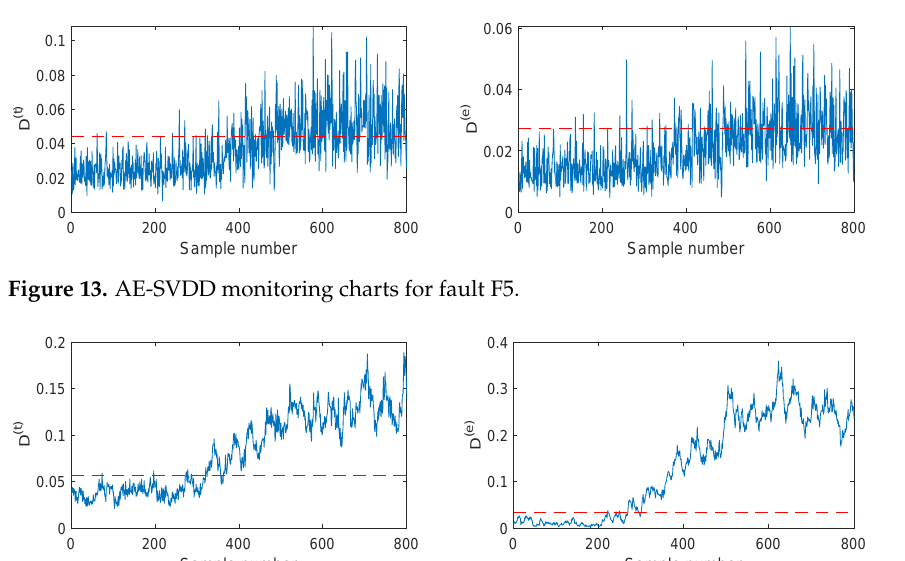
Figure 12. PCA-SVDD monitoring charts for fault F5.